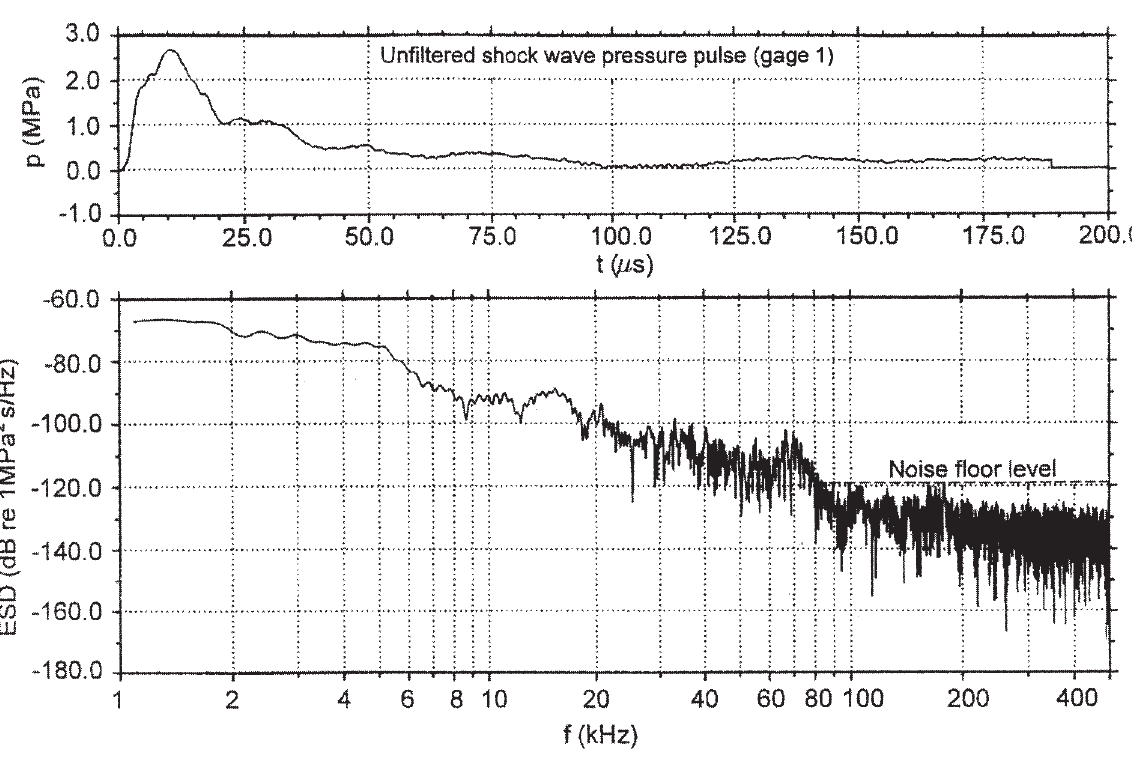
Fig. 6. Energy spectral density of shock wave measured by pressure gage